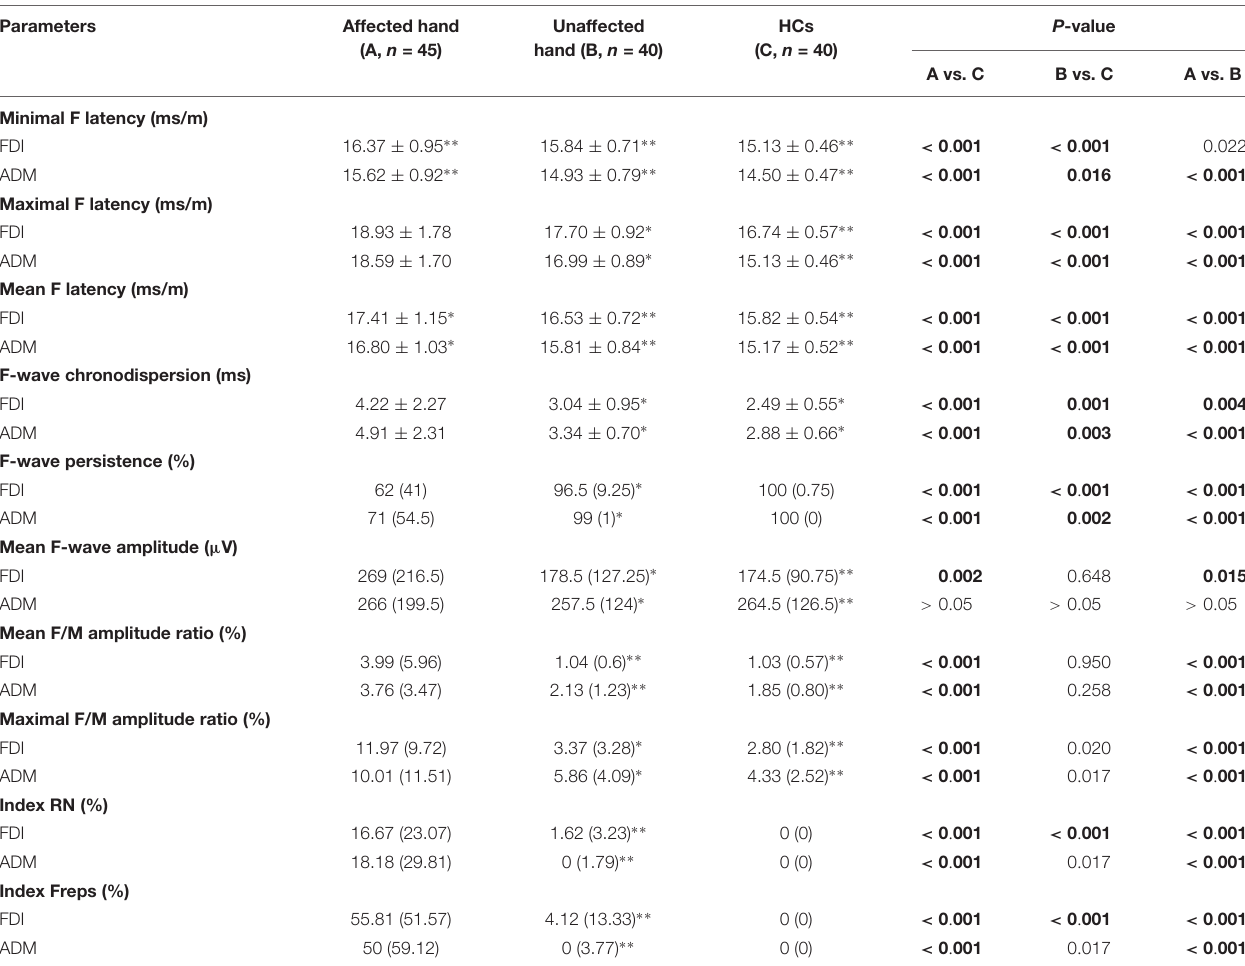
TABLE 3 | Results of F-wave variables in the ALS patients and the healthy